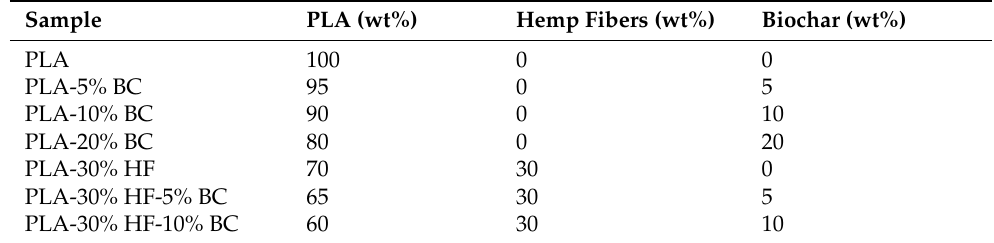
Table 1. Formulations of the prepared PLA-based